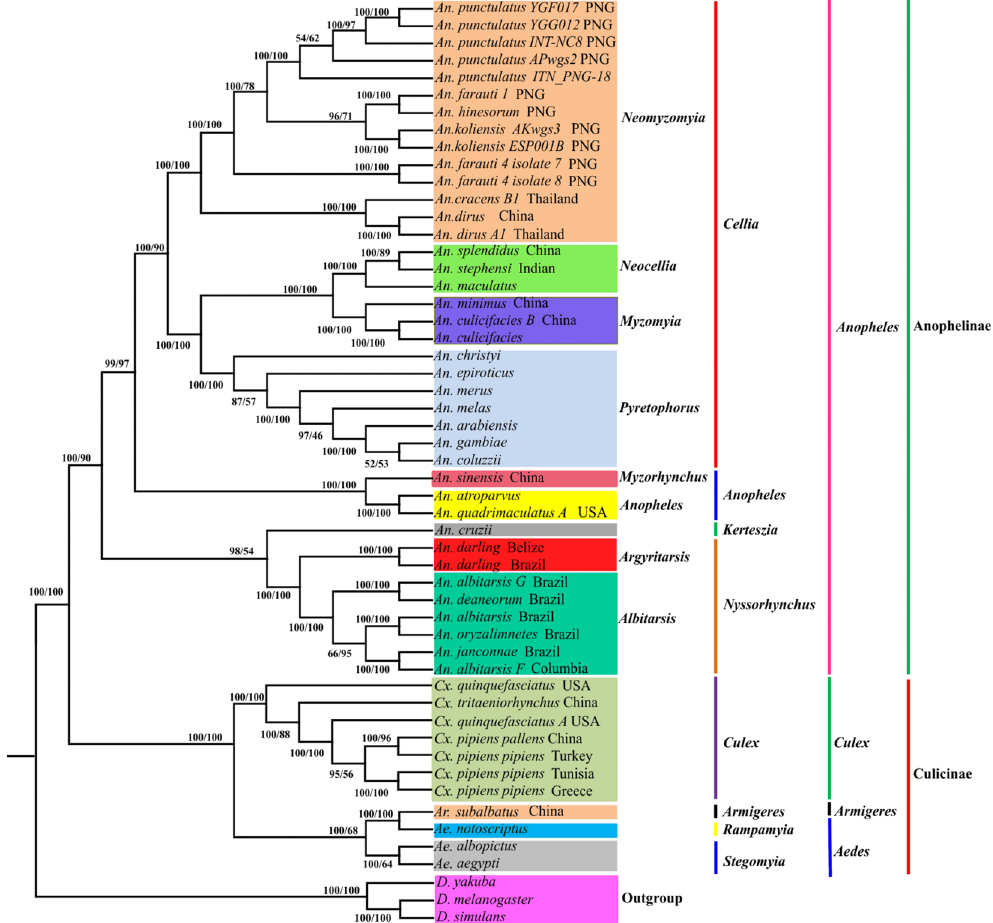
Figure 7. Reconstruction of phylogenetic tree determined by RAxML rapid bootstrap and Bayesian inference methods based on all sites (PCG123) of the concatenated protein-coding genes of 50 mosquito mitogenomes. Bayesian posterior probabilities (BPP) (left) and bootstrap support values (BP) are shown at relevant branches of the BI